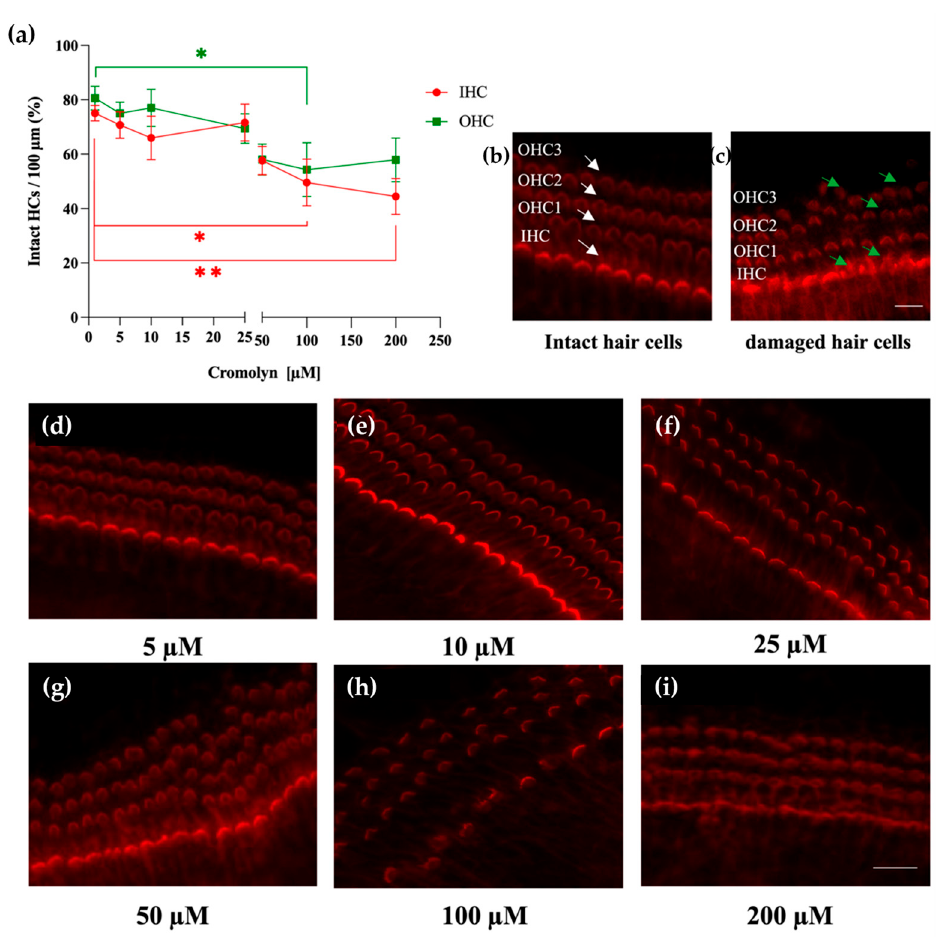
Figure 4. Cromolyn used at high concentrations decreases the numbers of IHCs and OHCs. ( a ) The intact hair cells were scored along the length of 100 µ m of the cochlear explant (spiral limbus containing OC), and the percentages of intact IHCs (red circles) and OHCs (green squares) were determined and plotted on the y -axis. The control explants (n = 4) were cultured for 24 h in a tissue culture medium. The treatment groups (n = 4 for each treatment) were cultured for 24 h with cromolyn at the following concentrations: 5 µM, 10 µM, 25 µM, 50 µM, 100 µM, and 200 µM. ( b , c ) Representative micrograph showing intact ( b ) and damaged ( c ) hair cells. Arrows point out intact HCs (white) and damaged HCs (green). Scale bar represents 10 µM. ( d – i ) Representative micrograph showing the HCs after 24 h of exposure to 5 µM, 10 µM, 25 µM, 50 µM, 100 µM, and 200 µM cromolyn. The cochlea explants were stained with phalloidin-iFluor 594. The scale bar represents 10 µm. Four independent experiments were performed; the data are reported as mean ± SEM. * p < 0.05; ** p < 0.01 (two-way ANOVA with Dunnett multiple comparison test).